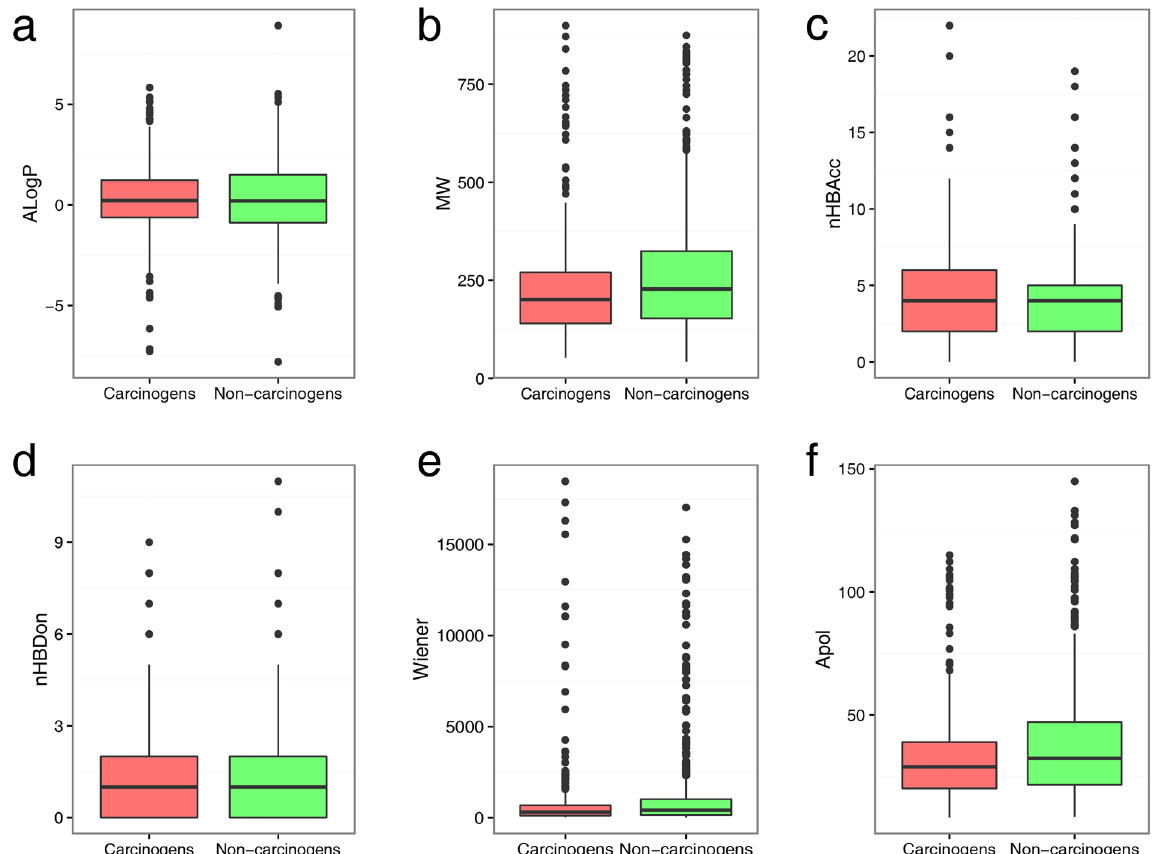
Figure 2. Box plot representing the molecular descriptors for carcinogens and non-carcinogens. Carcinogens and non-carcinogens are represented by red and green boxes,